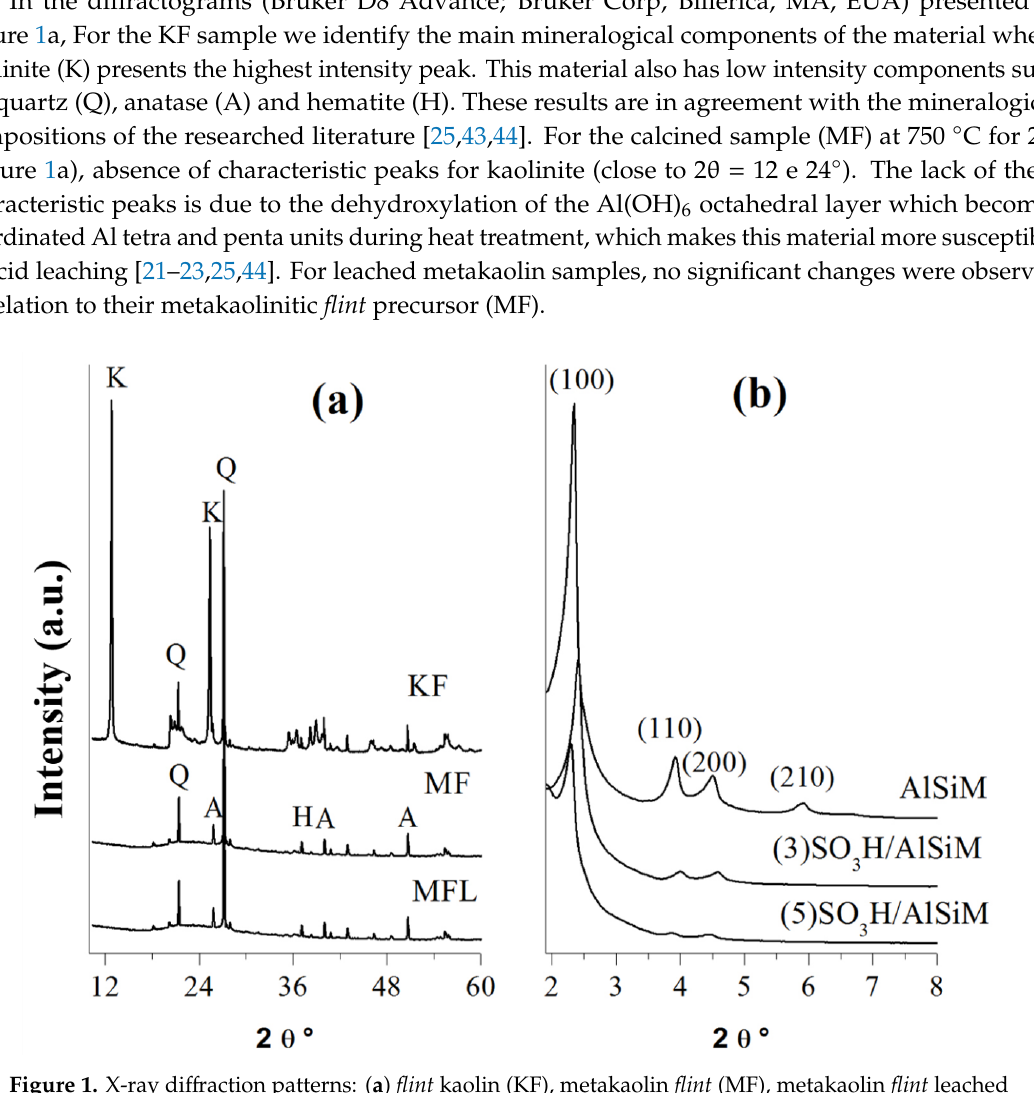
Table 1. XRF analysis results of the raw material and samples prepared.